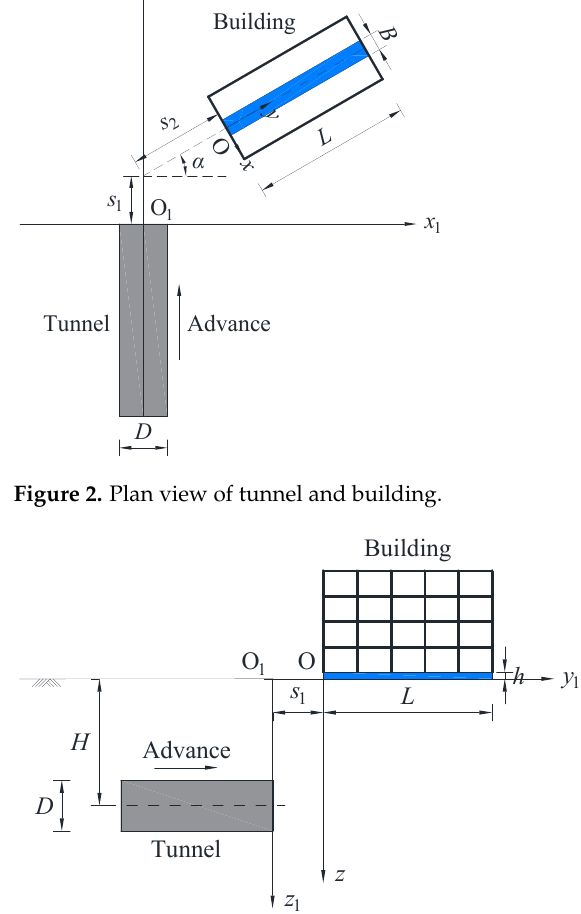
Figure 3. Profile view of building axis parallel to tunnel axis.